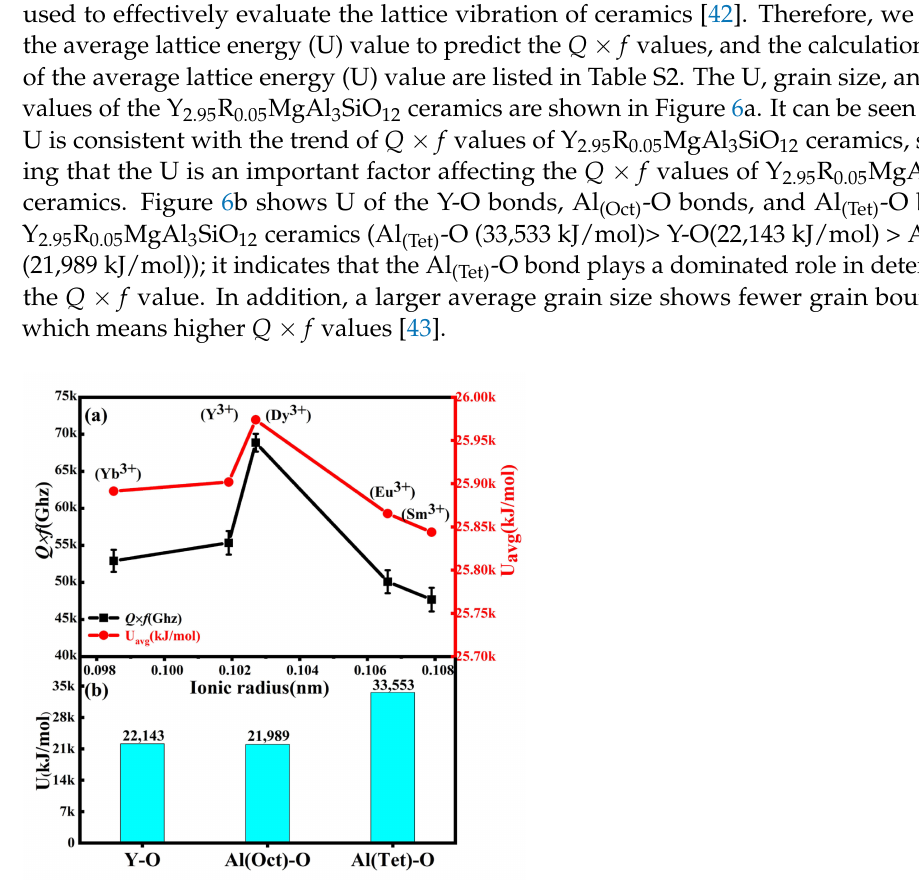
Figure 6. ( a ) Q × f , average lattice energy, and average grain size of Y 2.95 R 0.05 MgAl 3 SiO 12 ceramics; ( b ) The average U value of three types of